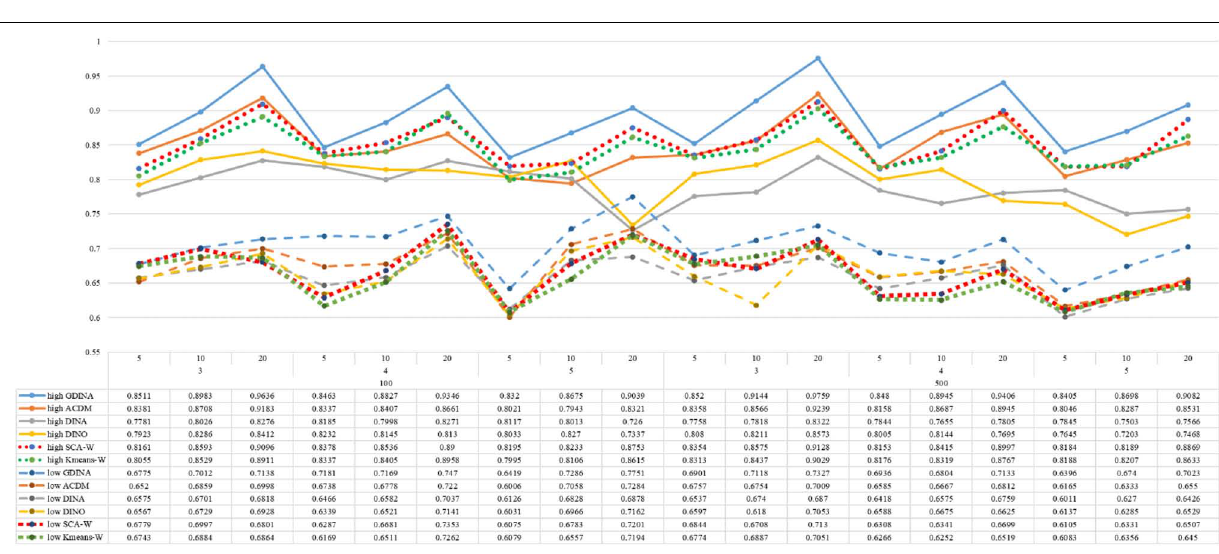
FIGURE 2 | Mean values of ω by SCA, K-means, and fitted models; True model =